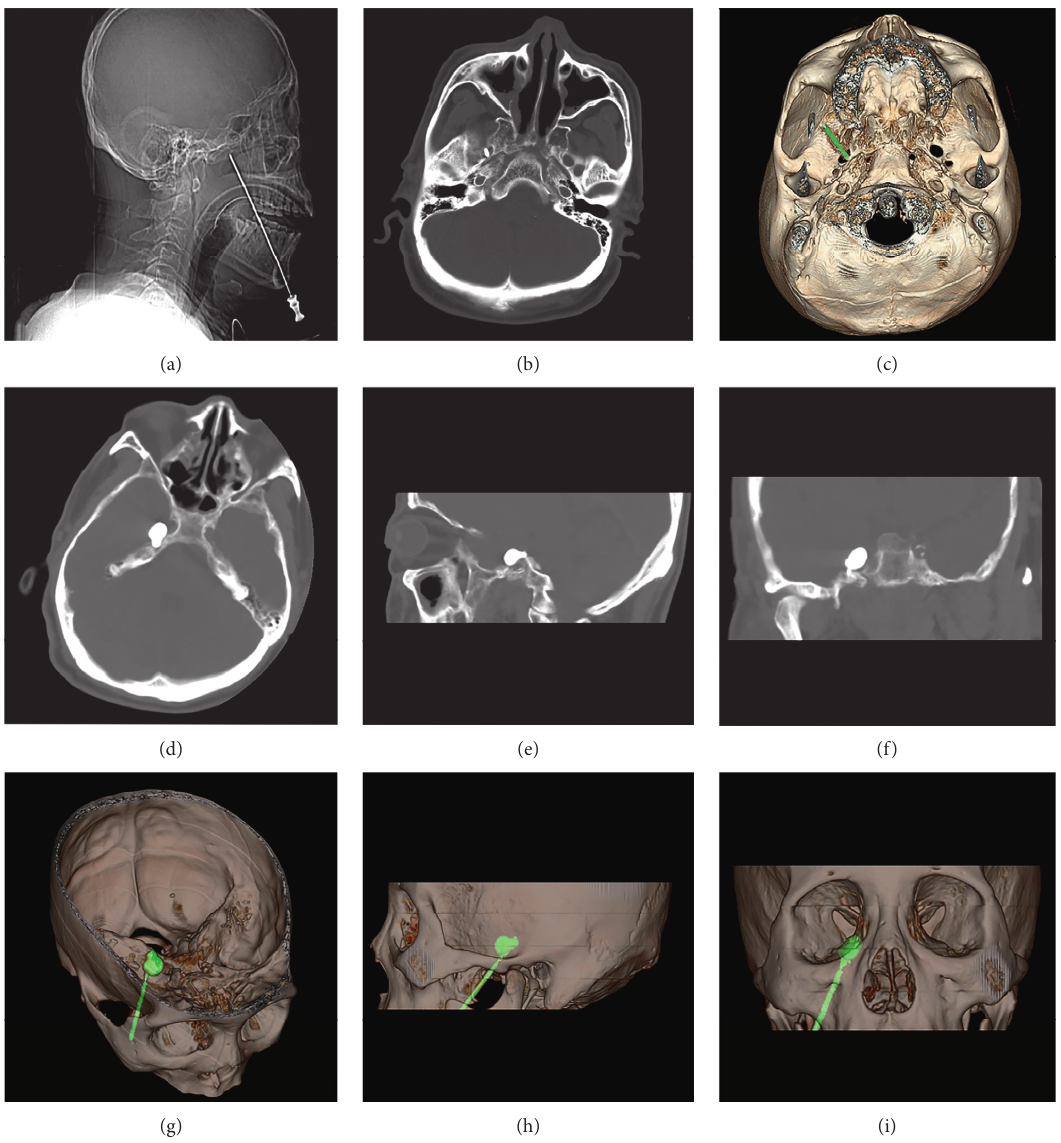
Figure 1: 2D images and reconstructed 3D-CT images during FO puncture. (a) Scout image of spiral CT during FO puncture; (b), (c) 2D and reconstructed 3D images of spiral CTshowing the spatial relationship between the needle and the targeted FO; (d-f) axial, sagittal, and coronal views of the pear-shaped balloon; (g-i) reconstructed 3D-CTimages provided confirmation of the position and shape of the